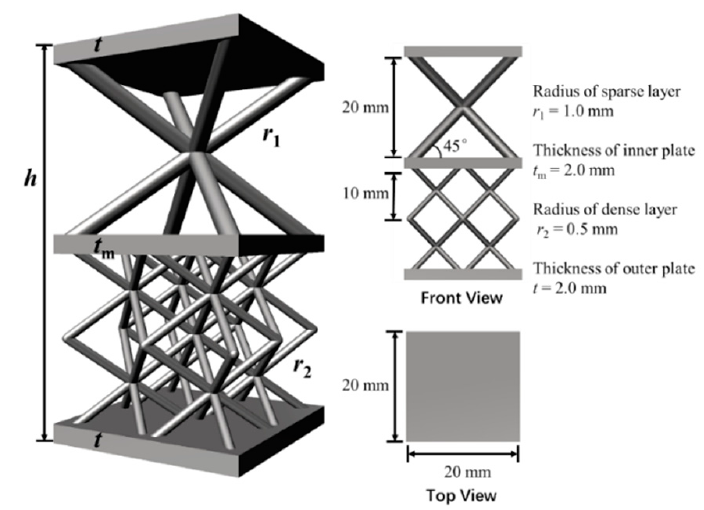
10 of 22 Figure 5. Flowchart of S-NIAH method to solve equivalent shear stiffness. 3. Numerical Examples of the Effect of Unit Cell Parameters on Equivalent Analysis In this study, we performed equivalent analysis of a Bi-layer lattice-filled structure using ANSYS, in which the lattice unit cell, as shown in Figure 2, is modelled using a beam element and shell element. The equivalent stiffness, D , and the equivalent shear stiffness, K , can be obtained based on the flowcharts shown in Figures 3 and 5. Following this, the equivalent model is modelled using shell elements in the equivalent analysis and the ma- terial properties are obtained. 3.1. Calculation of Equivalent Stiffness of Single Bi-layer Lattice Cell Body centred cubic (BCC) lattices as a positive Poisson’s ratio structure show high strength over a wide range of temperatures and large strain states. The considered exam- ple is a single Bi-layer lattice unit cell, as shown in Figure 6. The Bi-layer lattice structure is composed of two lattices layers: sparse and dense layers. However, the sizes of the in- filled lattices are different. The height of each layer is 20 mm. The radii of all robs in the